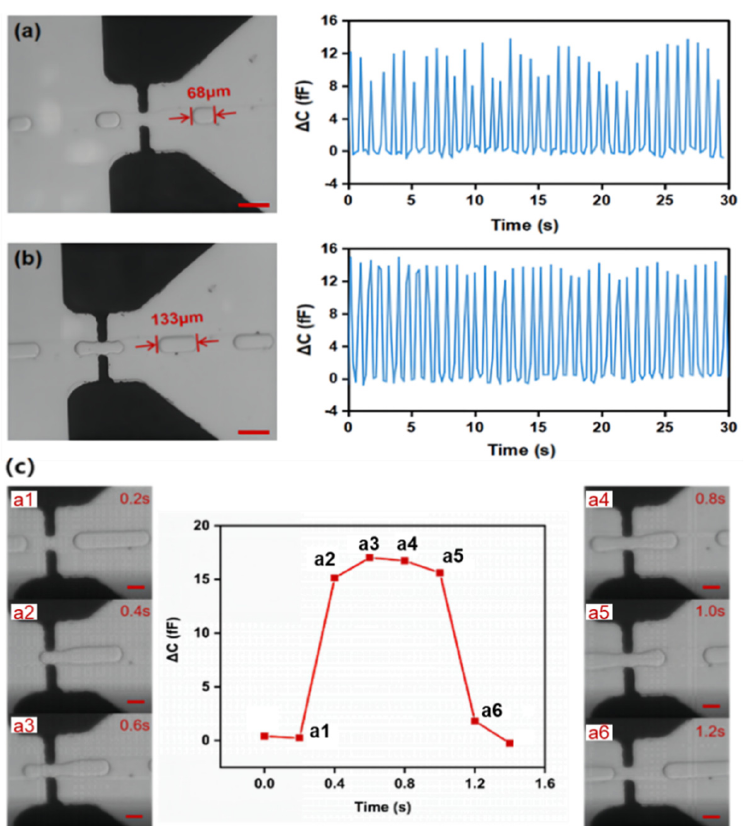
Figure 8. Droplet capacitance detection: ( a ) Capacitance signal caused by 68 μ m droplets over 30 s. Scale bar, 100 μ m. ( b ) Capacitance caused by 133 μ m droplets over 30 s. Scale bar, 100 μ m. ( c ) Capacitance response process caused by a 248 μ m droplet. Subfigures a1–a6 show the position of the droplet at different times. Scale bar, 50 μ m.